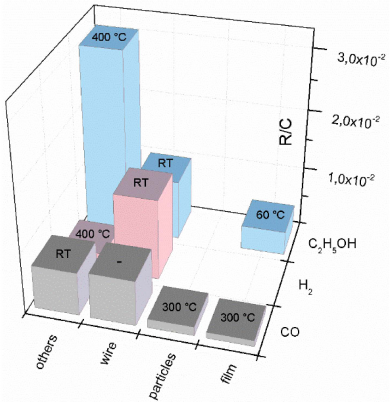
Figure 4. Relative sensor response (R) to ppm concentration (C) of H 2 , C 2 H 5 OH and CO against operating temperature for different zinc oxide morphologies (based on the maximum response for the minimum concentration shown in Table 2 for each morphology/gas combination). Other structures: NR, NB, CL, flakes.